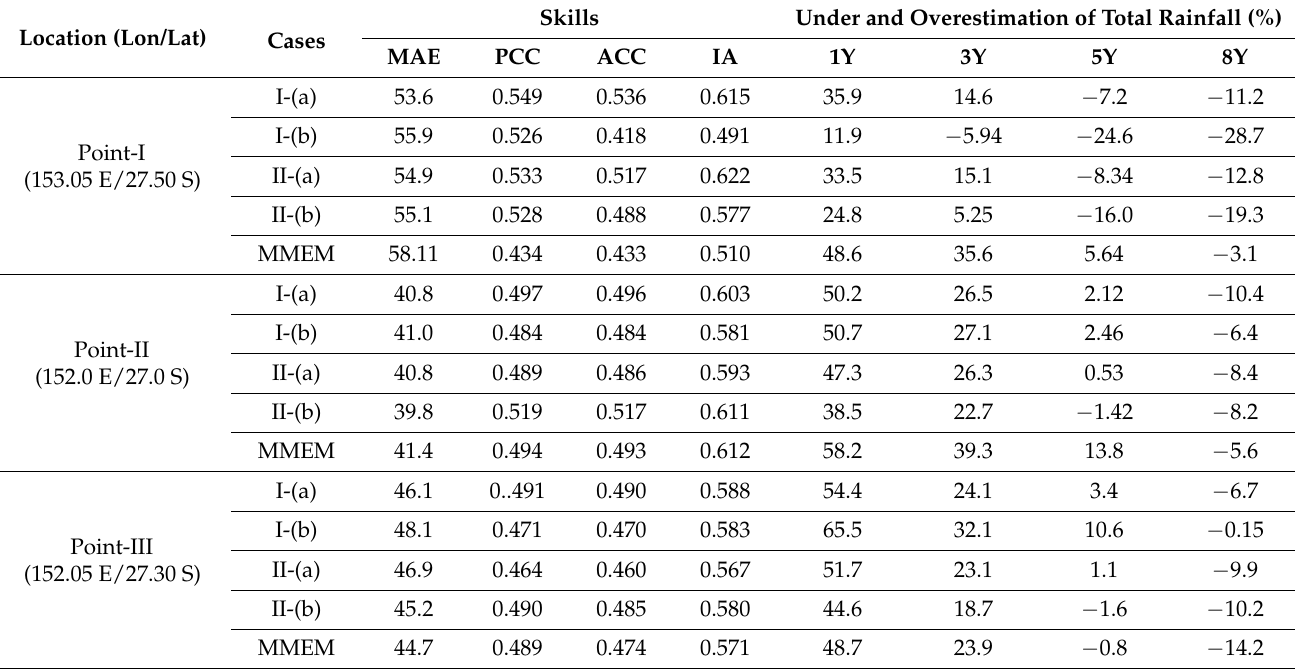
Table 2. Comparison of skills and total rainfall prediction among the different cases of FBP